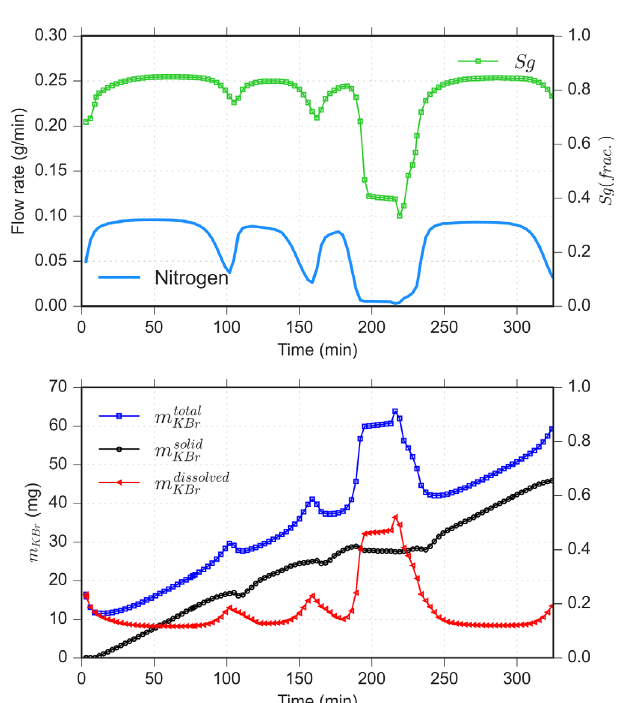
Fig. A4. Published data [4]: Simulated gas saturation, gas fl ow rate, and BKr salt accumulation (total, solid and dissolved) during gas dry-though experiments (modi fi ed graph from fi gure 18 of [4]). The mass of salt is given for a pore volume of 0.31 cc.